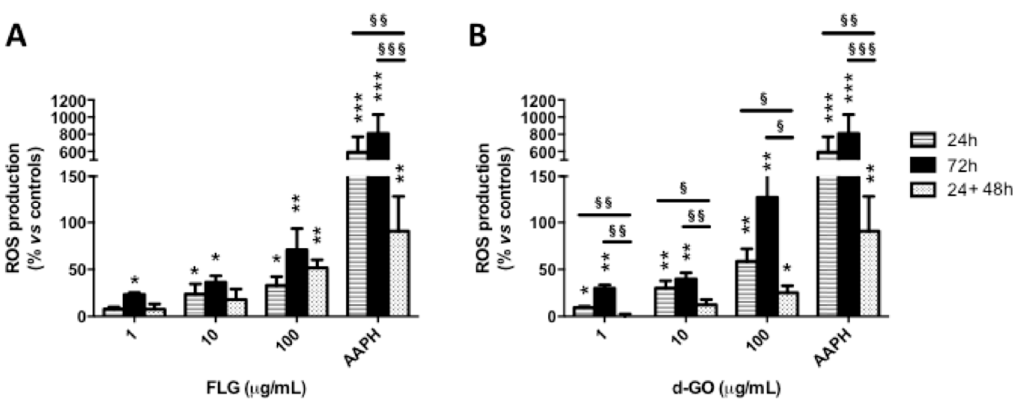
Figure 3. Reactive oxygen species (ROS) production by HaCaT cells exposed to GBMs. HaCaT cells were exposed to FLG ( A ) or d-GO ( B ) (1, 10 and 100 μ g/mL) for 24 or 72 h (continuous exposure), or for 24 h followed by 48 h recovery in GBM-free medium (recovery exposure; 24 + 48 h) before the evaluation of ROS production using the 2 ′ ,7 ′ -dichlorofluorescin diacetate (DCFDA) fluorescence probe. As a positive control, cells were exposed to 0.3 mg/mL 2,2 ′ -azobis(2-amidinopropane) dihydrochloride (AAPH). Results are the mean ± SE of 3 independent experiments performed in triplicate. Statistical differences vs. negative controls: *, p < 0.05; **, p < 0.01; ***, p < 0.001 (One-way ANOVA and Bonferroni’s post-test). Statistical differences between continuative and recovery conditions: § , p < 0.05; §§ , p < 0.01; §§§ , p < 0.001 (Two-way ANOVA and Bonferroni’s post-test).